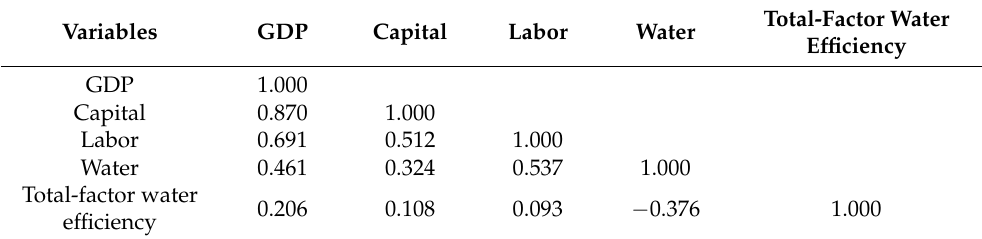
Table 2. The correlation matrix for